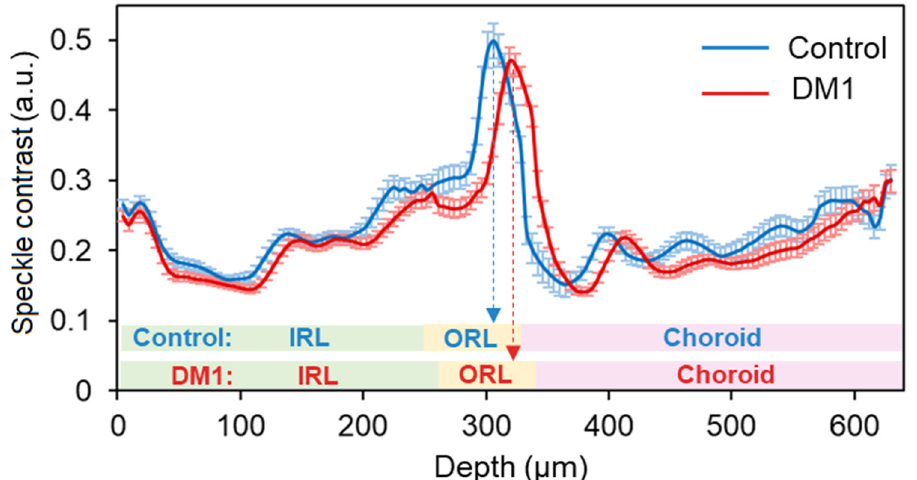
Figure 4. Mean speckle contrast expressed in arbitrary units (a.u.) for the control group ( n = 32), in blue, and for the DM1 group ( n = 42), in red. Error bars represent standard error. In the bottom part of the plot mean layer thickness per group is shown. Dashed arrows indicate the maximum speckle contrast position per group.